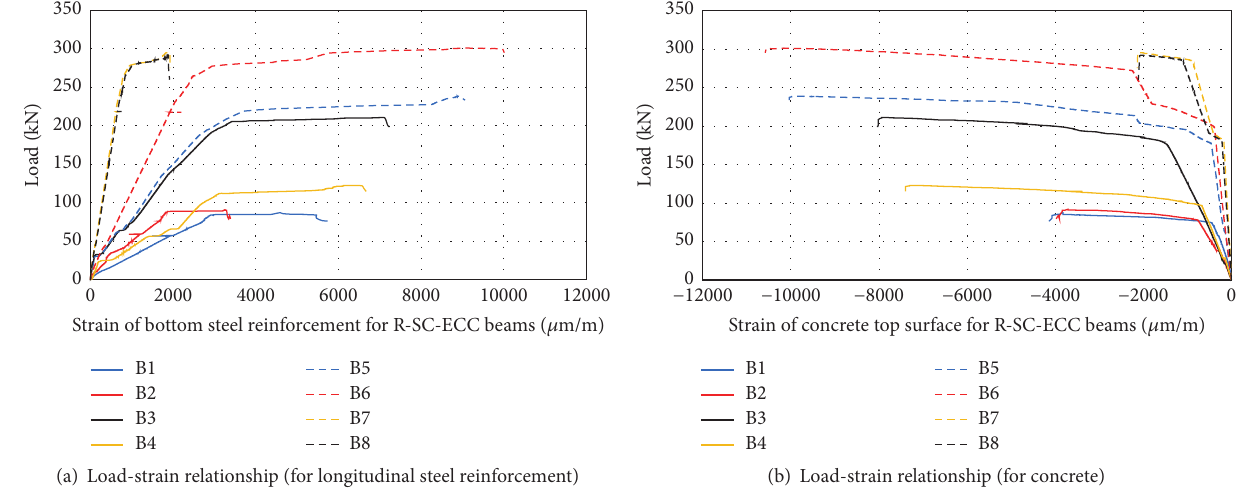
Figure 11: Strain of steel bars and concrete.